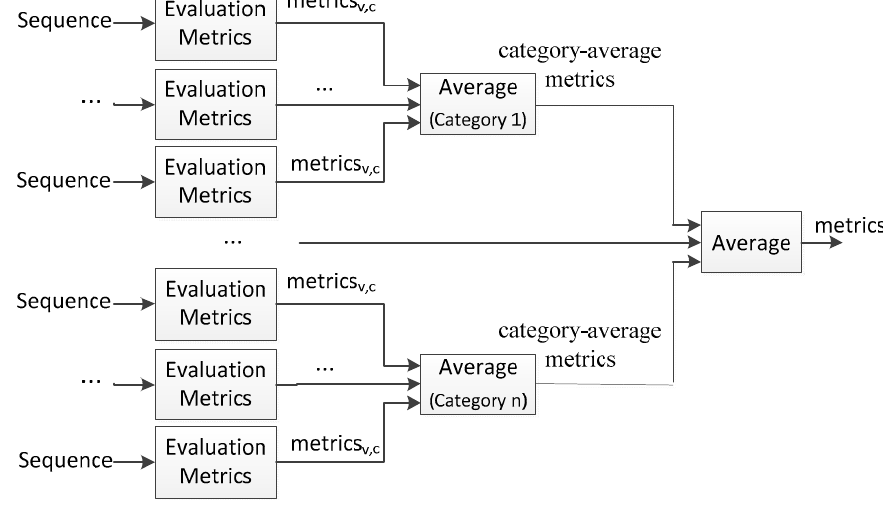
Figure 9. Evaluation metrics in CDW challenges.